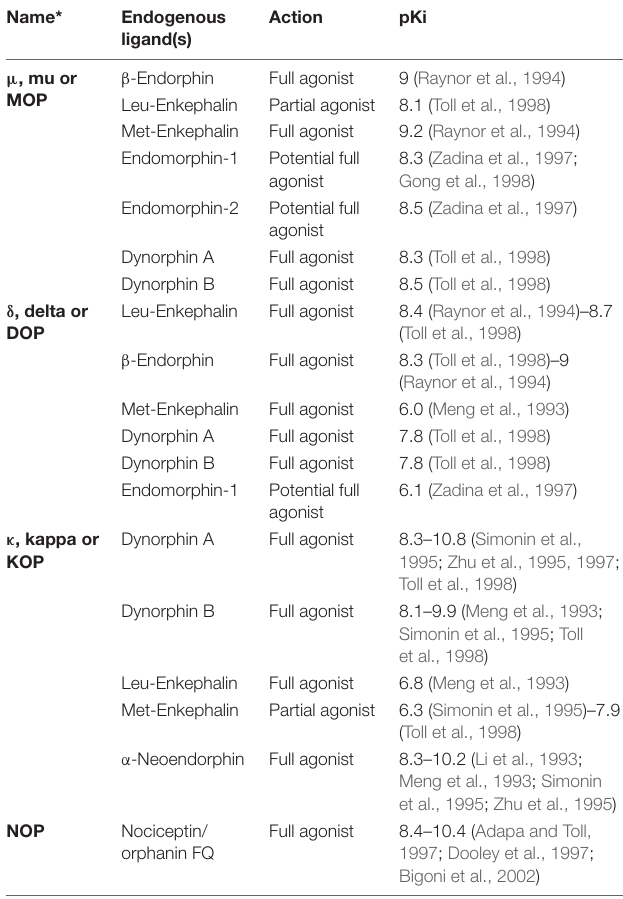
TABLE 1 | Opioid peptide receptors and their